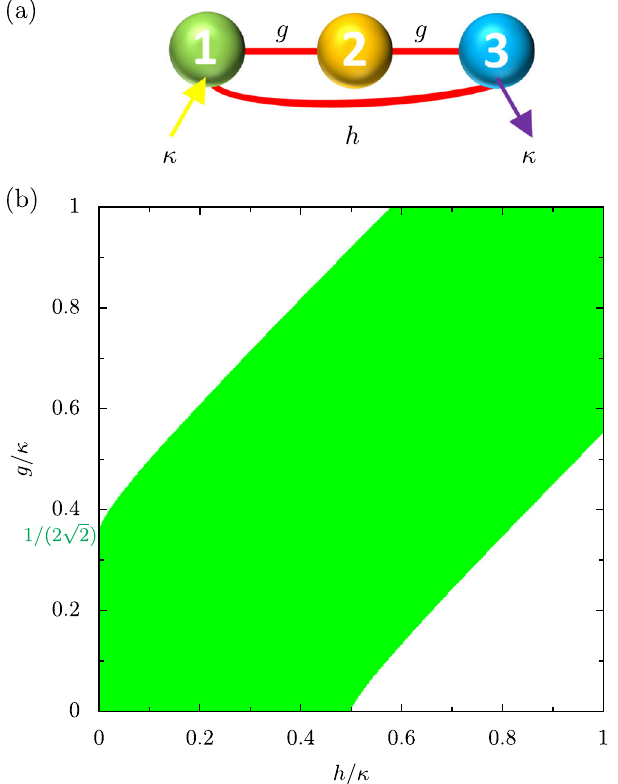
Fig. 4 The effect of long-range interactions. a A sketch of the PT -symmetric trimer (colored spheres) beyond nearest-neighbor coupling, where the fi rst-neighbor coupling constant is g , and the second-neighbor coupling constant is h . The fi rst oscillator (green sphere) is subject to gain κ (yellow arrow), and the fi nal oscillator (cyan sphere) to loss κ (purple arrow). b The PT symmetry phase diagram of the trimer, given by the evolution of the exceptional point ( g / κ ) 3 with the fi rst and second-neighbor couplings g and h , both in units of κ [Eq. (26)]. White: unbroken phase. Green: broken